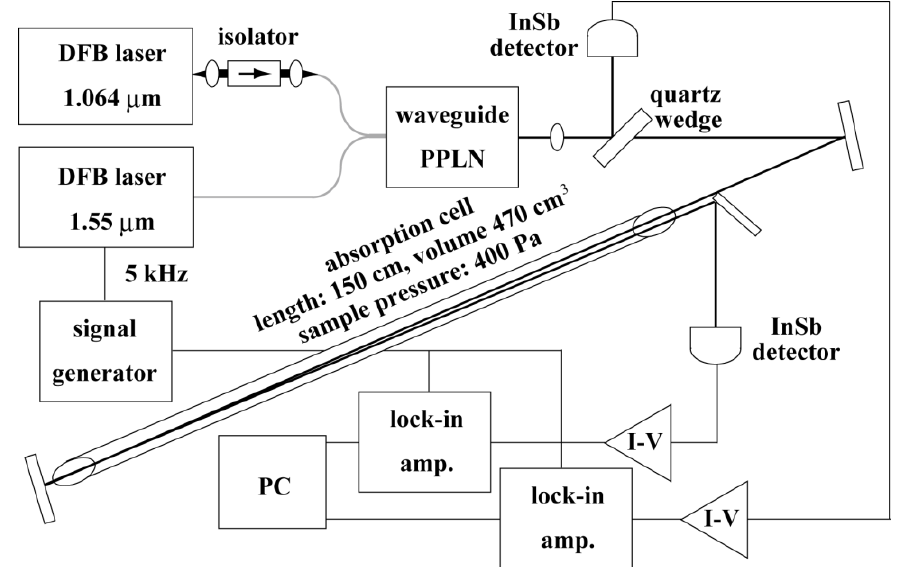
Figure 1. Schematic diagram of the experiment set-up. DFB: distributed feedback laser diode. I-V: current-voltage